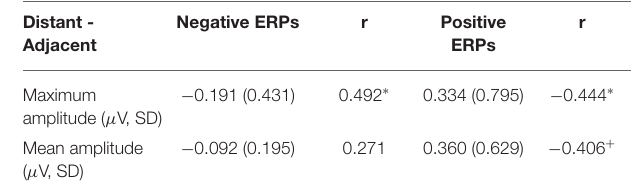
TABLE 3 | Effect sizes of the ERPs for syntactic integration in Quantifier First and their correlations with Japanese Reading Span Test